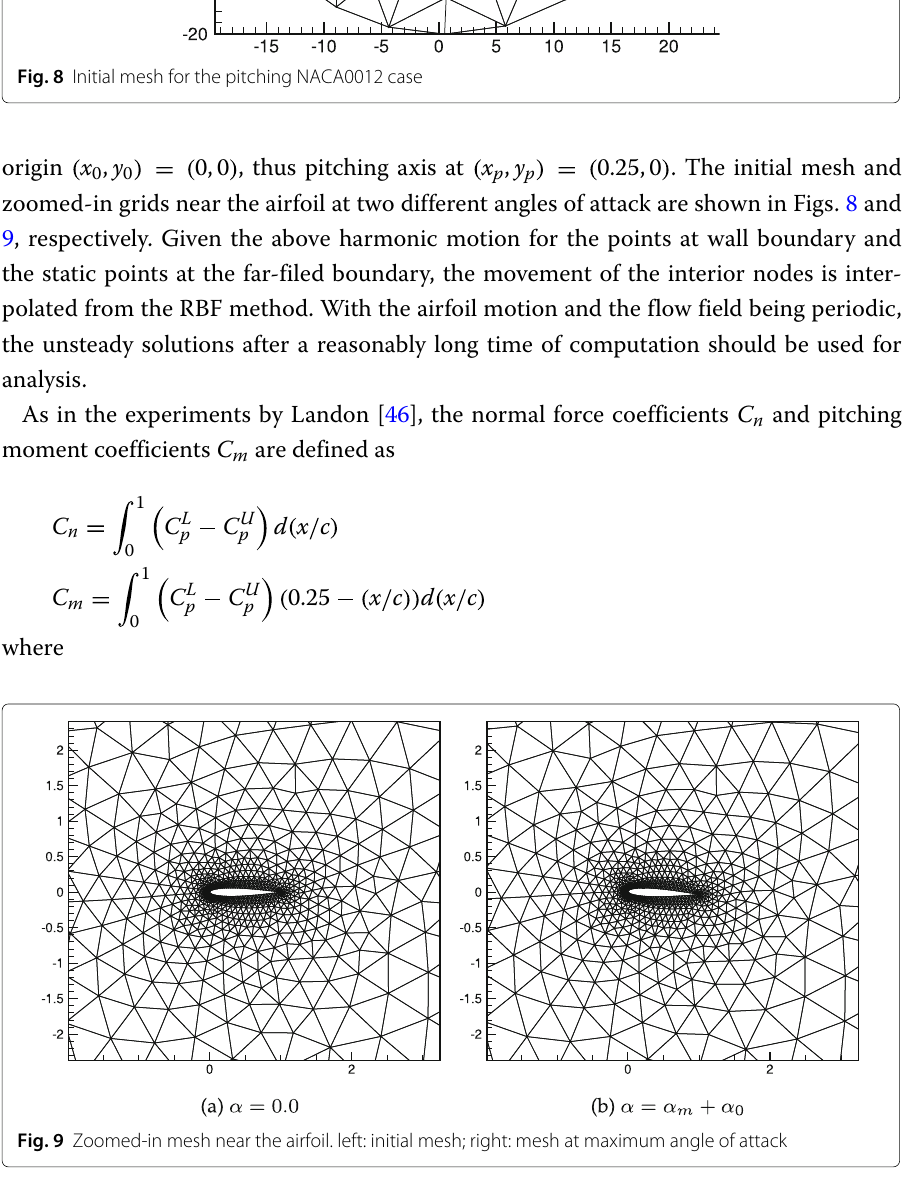
Fig. 8 Initial mesh for the pitching NACA0012 case